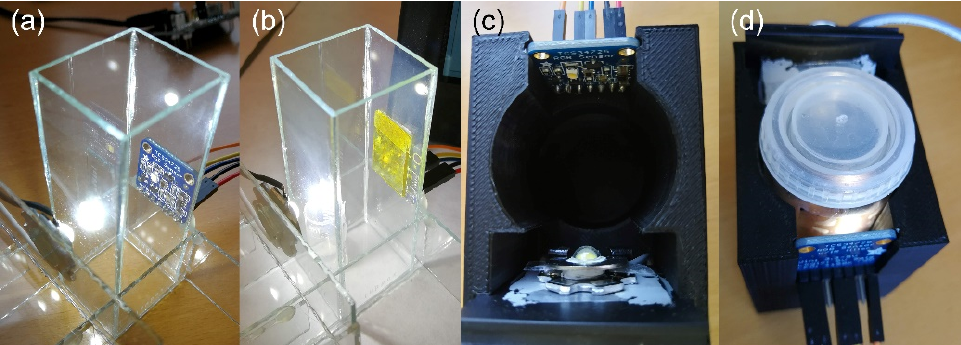
Figure 2. Measuring setup containing the sensor, light source, and sensing film. ( a ) Empty glass sample holder, ( b ) glass sample holder with a film for the detection of phosgene, ( c ) empty 3D-printed PLA sample holder, and ( d ) 3D-printed PLA sample holder with a glass vial containing a film for the detection of biogenic amines.